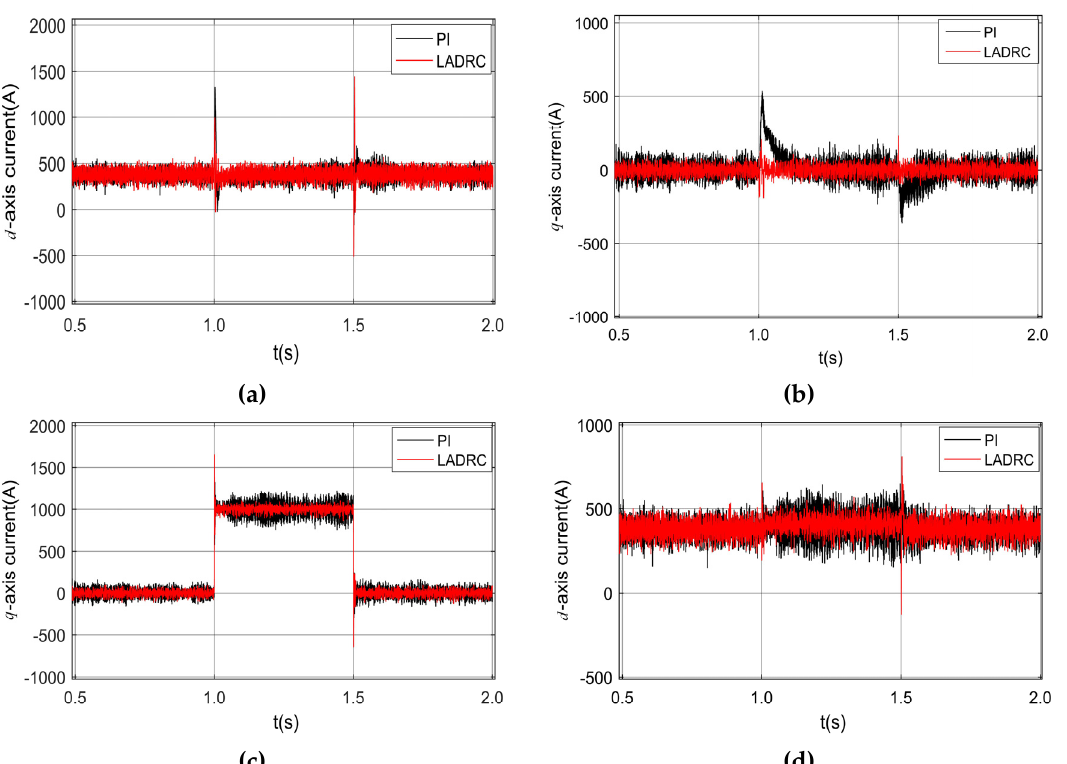
Figure 12. The change of reference current of d -axis and q -axis corresponding to the change of actual current of q -axis and d -axis under two control modes ( a ) d -axis reference current change ( b ) q -axis actual current ( c ) d -axis reference current change ( d ) q -axis actual current.